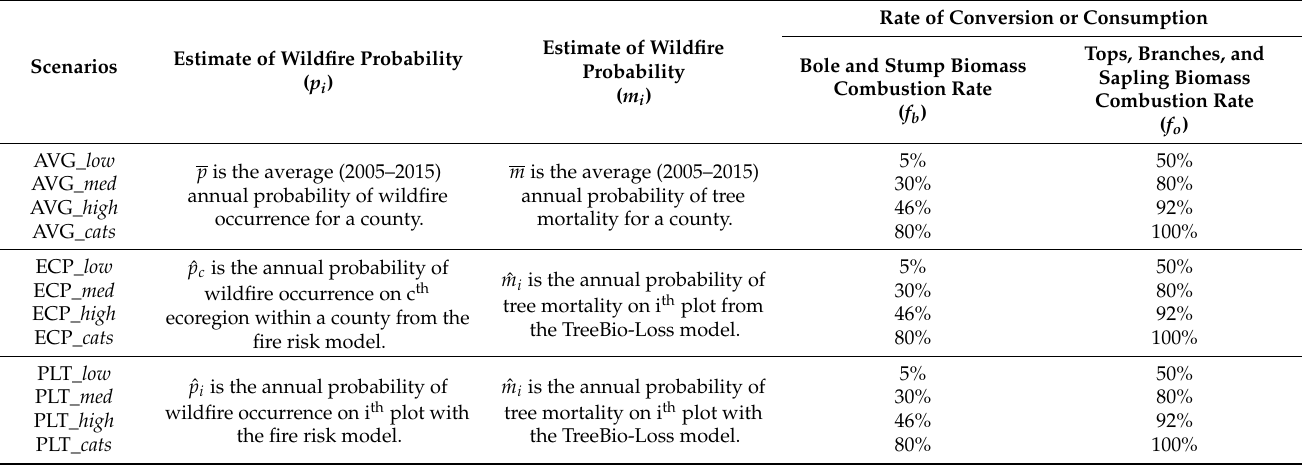
Table 2. Different scenarios to estimate CO 2 emissions under different conversion rates and probabil- ity estimation methods in the continental United